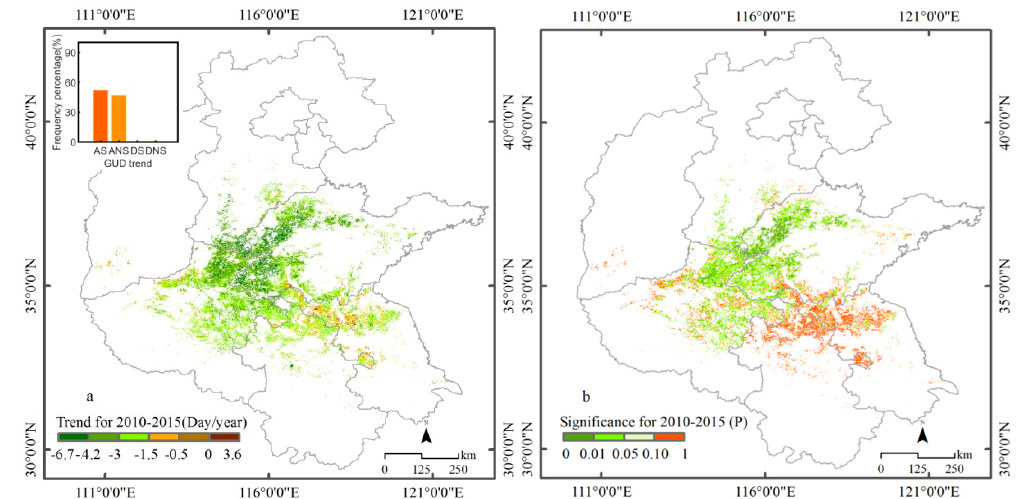
Figure 8. Spatial trends of GUD in the period of 2010–2015 ( a ), and its significance levels ( b ). The inset plot presents the frequency percentage of GUD trends. AS, ANS, DS and DNS indicates advanced significantly, advanced but not significantly, delayed significantly, delayed but not significantly, at p < 0.05 level, respectively.